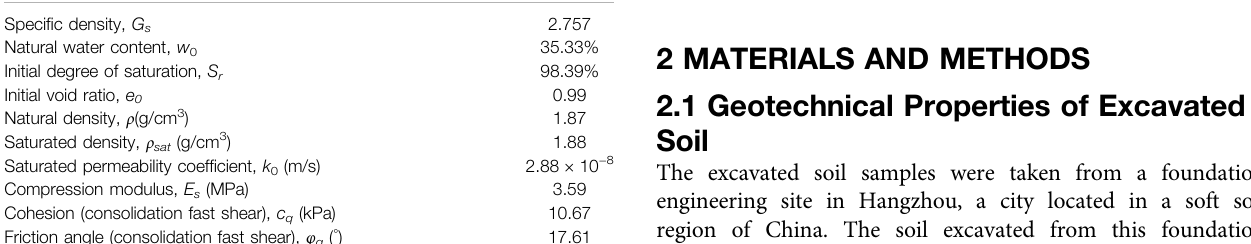
TABLE 1 | Geotechnical properties of the excavated soil sample.